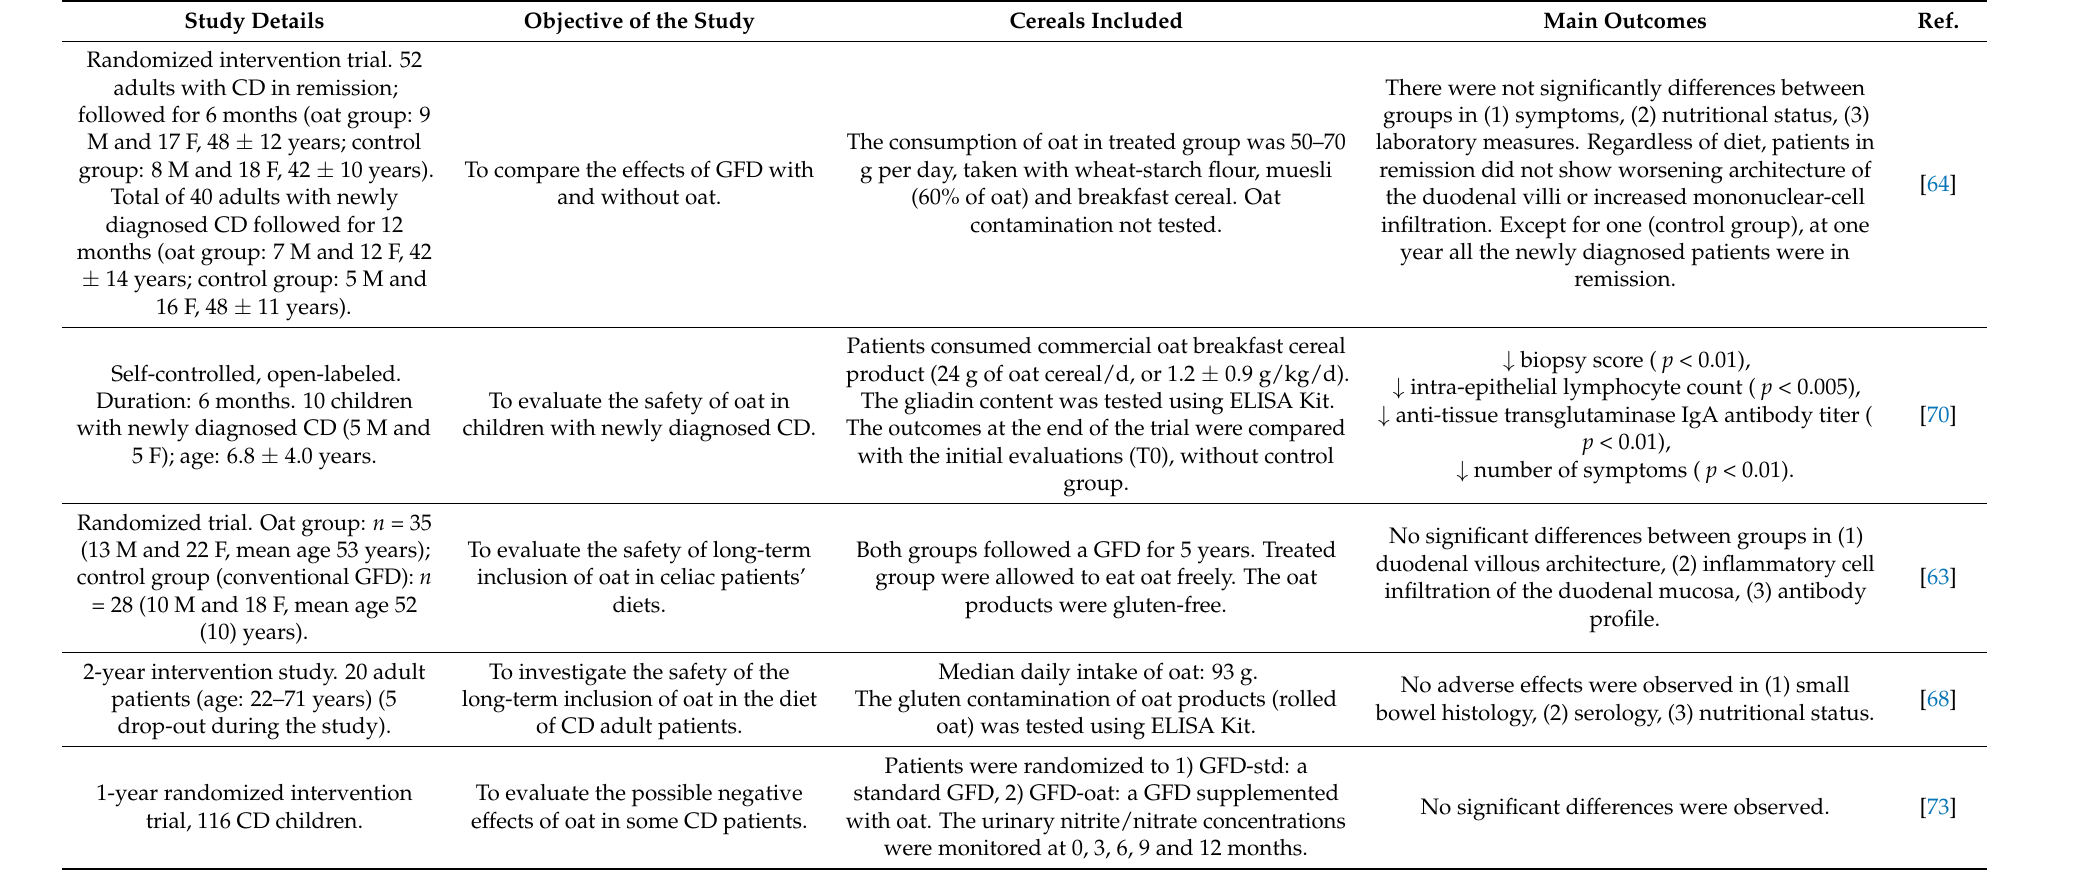
Table 8. In vivo studies on the toxicity of A. sativa for celiac subjects with positive